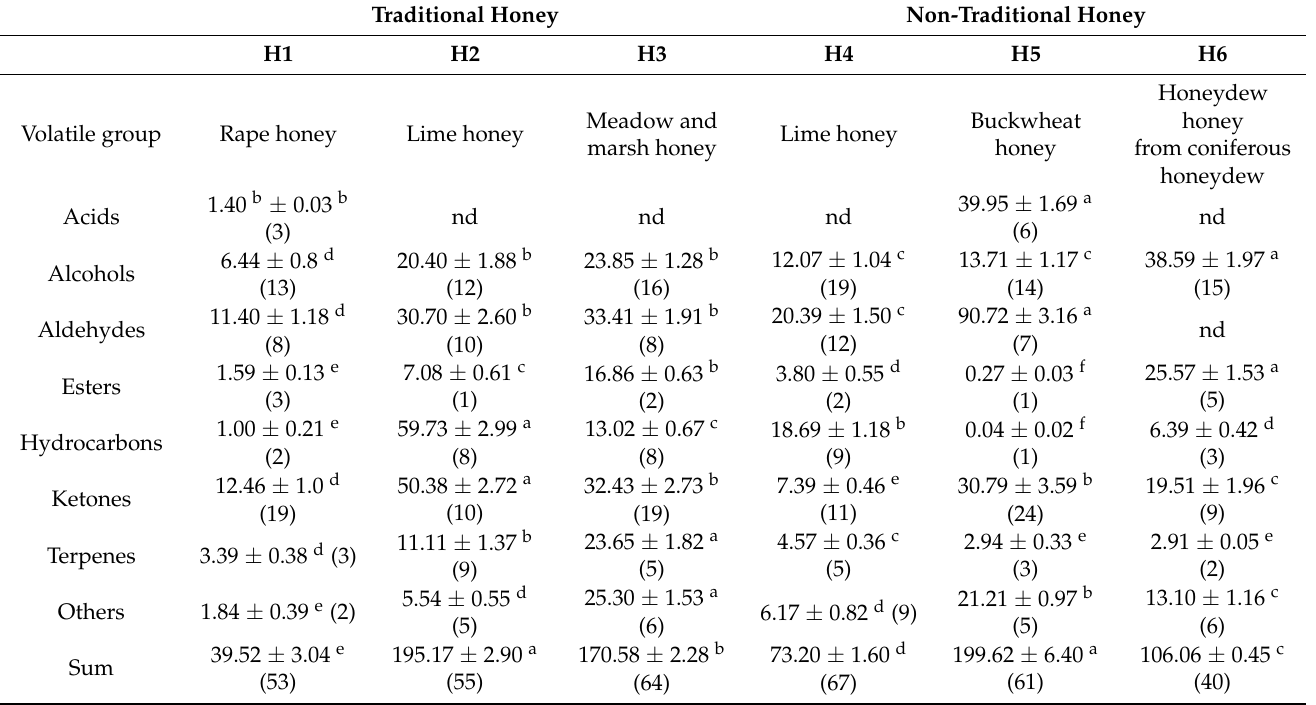
Table 4. Content of volatile compounds [ µ g/kg] determined in analyzed honey samples.